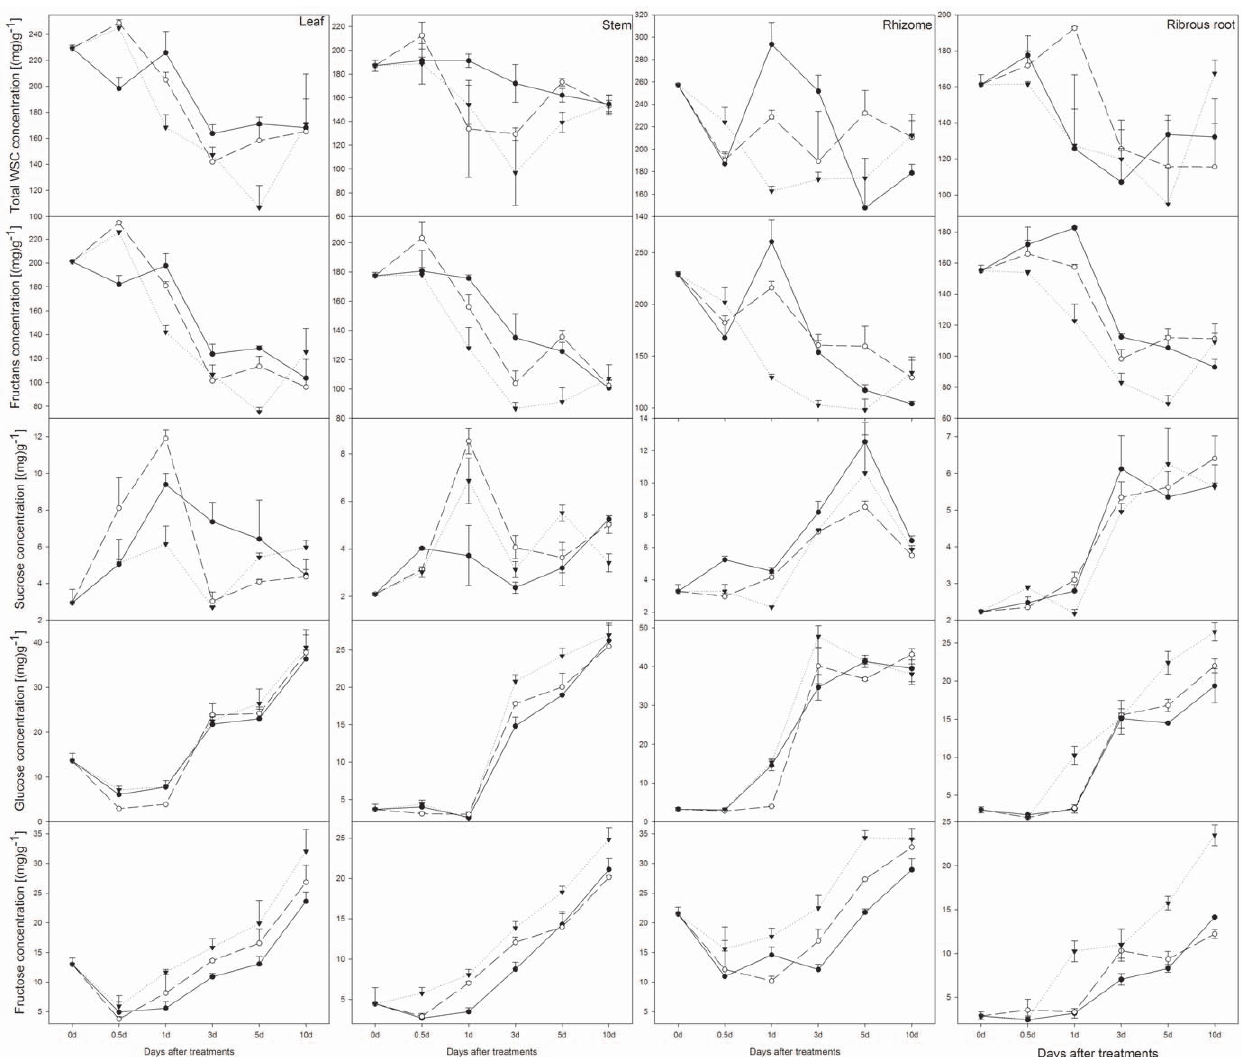
Height AGB BGB Tillers Buds